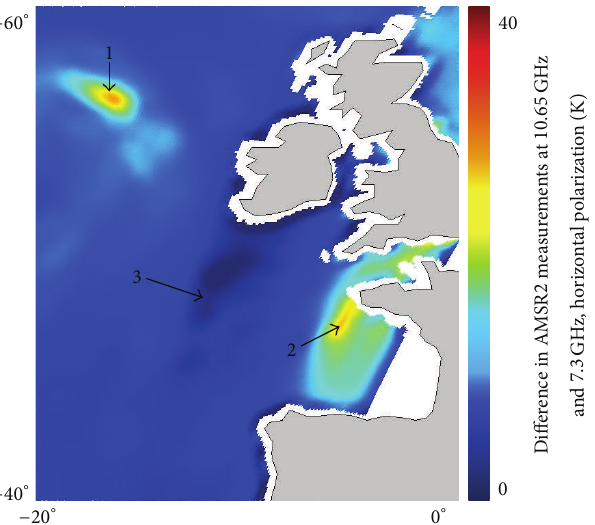
10.65 GHz and 7.3 GHz, horizontal polarization (H), on 3 September 2012 3:20 UTC. 1, area of precipitation, 2, RFI at 10.65 GHzH, and 3, RFI at 7.3